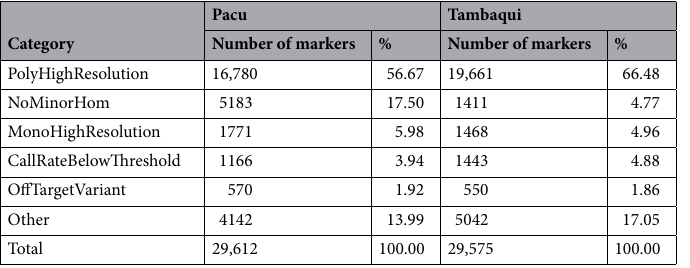
Table 3. Summary of the SNP classification according to their performance in the Axiom SerraSNP array of each species.